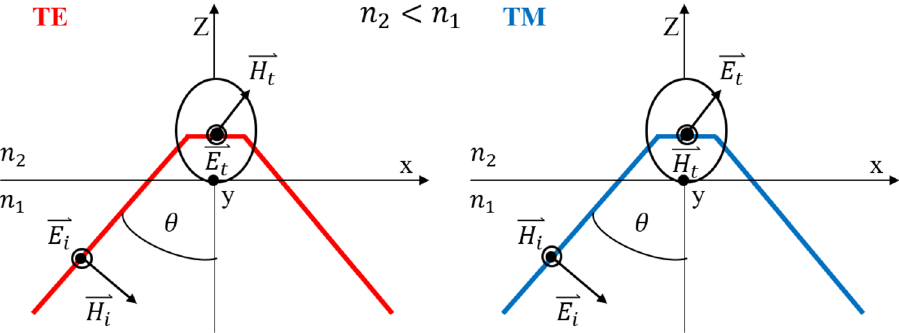
Figure 1. Polarization state of evanescent waves at total internal reflection for TE and TM